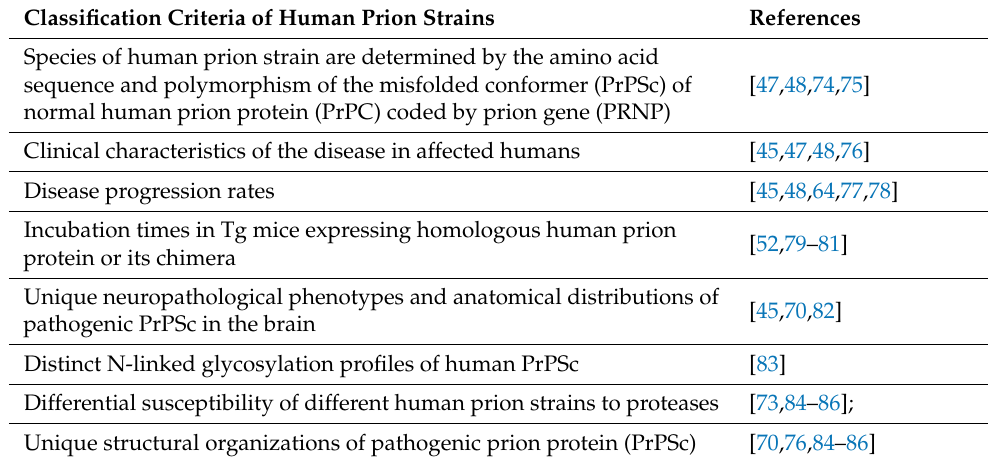
Table 1. Classification criteria of human prion strains. Classification Criteria of Human Prion